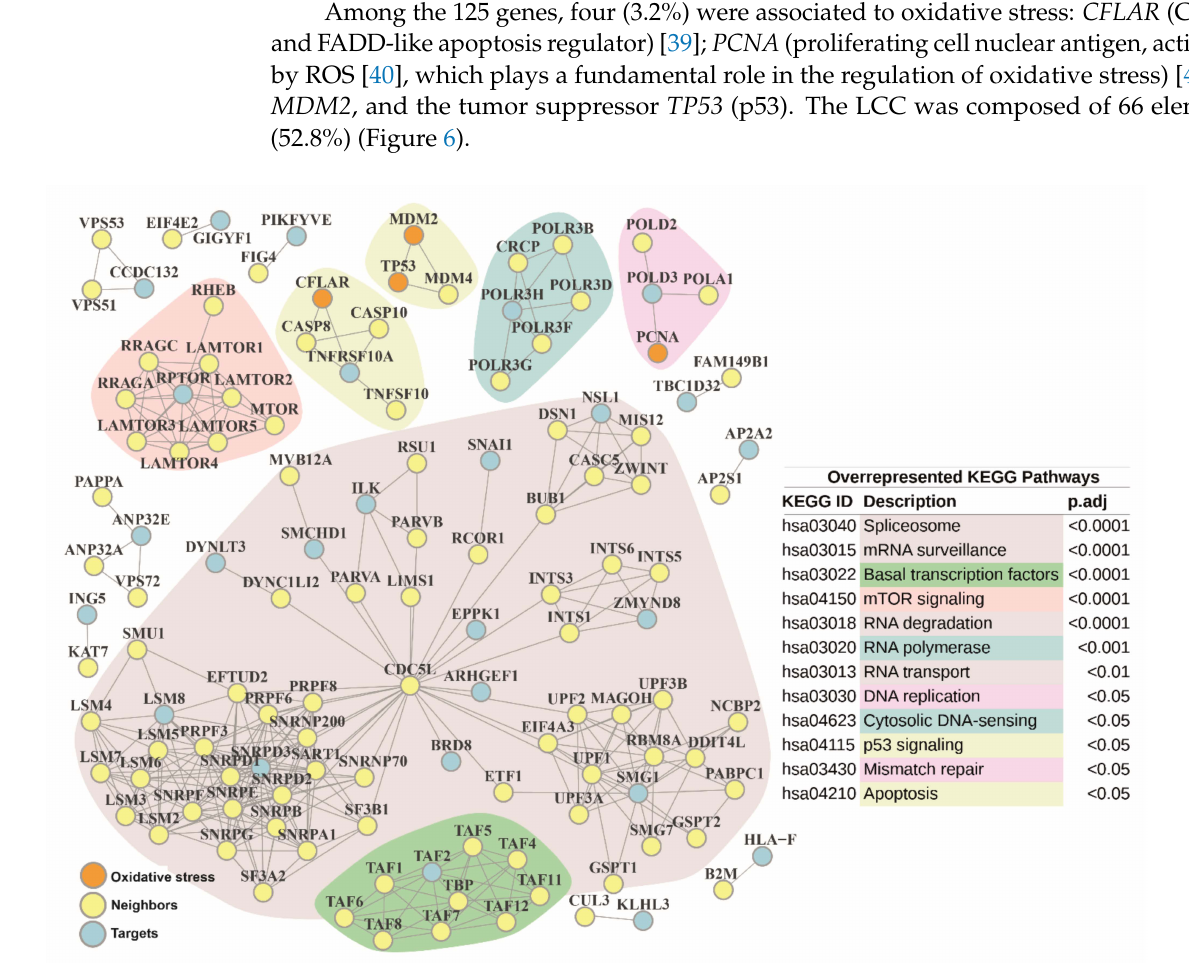
Figure 6. Protein-protein Interaction network built with siRNA target genes and 1st shell interactors from STRING database. Very high confidence 1st shell (direct) interactions were selected (minimum score of 900). Neighbors are highlighted in yellow. siRNA target genes are colored in blue. Genes related to oxidative stress are colored in orange. Main network submodules are marked with different background colors, according to the associated significantly enriched KEGG pathway obtained from the over-representation analysis (ORA) over the complete protein-protein interaction (PPI) network. Corresponding KEGG pathway identifiers (ID) and description are shown on the right. They are sorted by adjusted p -values retrieved from